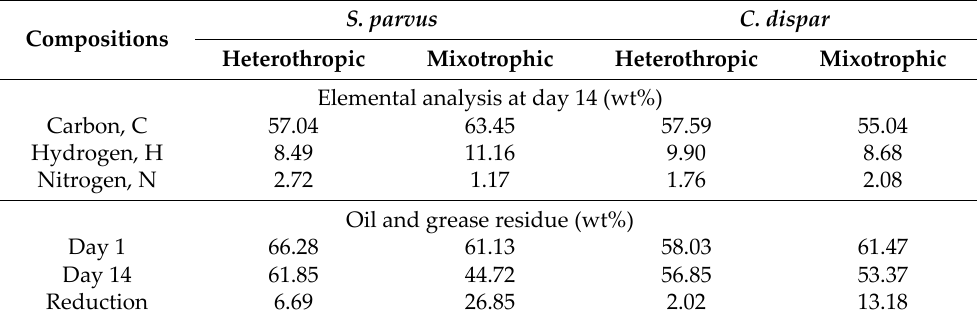
Figure 6. BOD removal efficiency throughout the 14-day period of cultivation in 1 L of POME for ( a ) S. parvus and ( b ) C. dispar , together with removal efficiency in 5 L of POME for ( c ) S. parvus and ( d ) C. dispar. Table 2. Oil and grease residue together with oil reduction at day 1 and day 14 under the heterotrophic and mixotrophic modes for both S. parvus and C. dispar with the optimum 20% cell